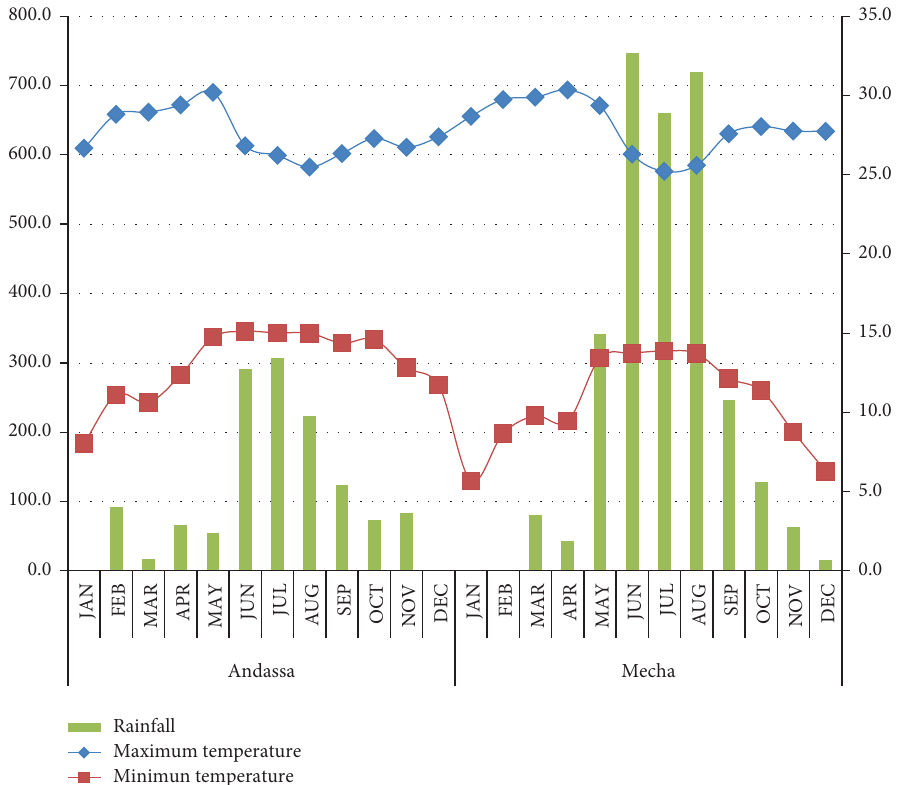
Figure 1: Monthly rainfall (mm) and maximum and minimum temperature ( ° C) of experimental